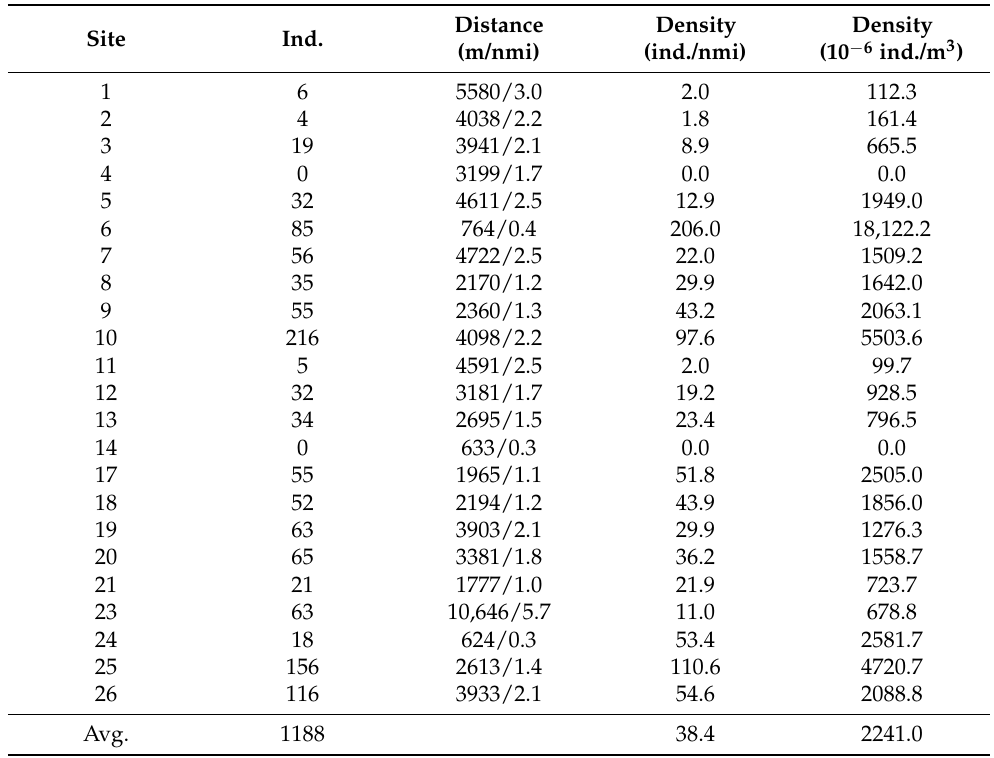
Table 6. Distribution density of jellyfish using the echo counting method in the Southern Sea and Jeju coastal waters.